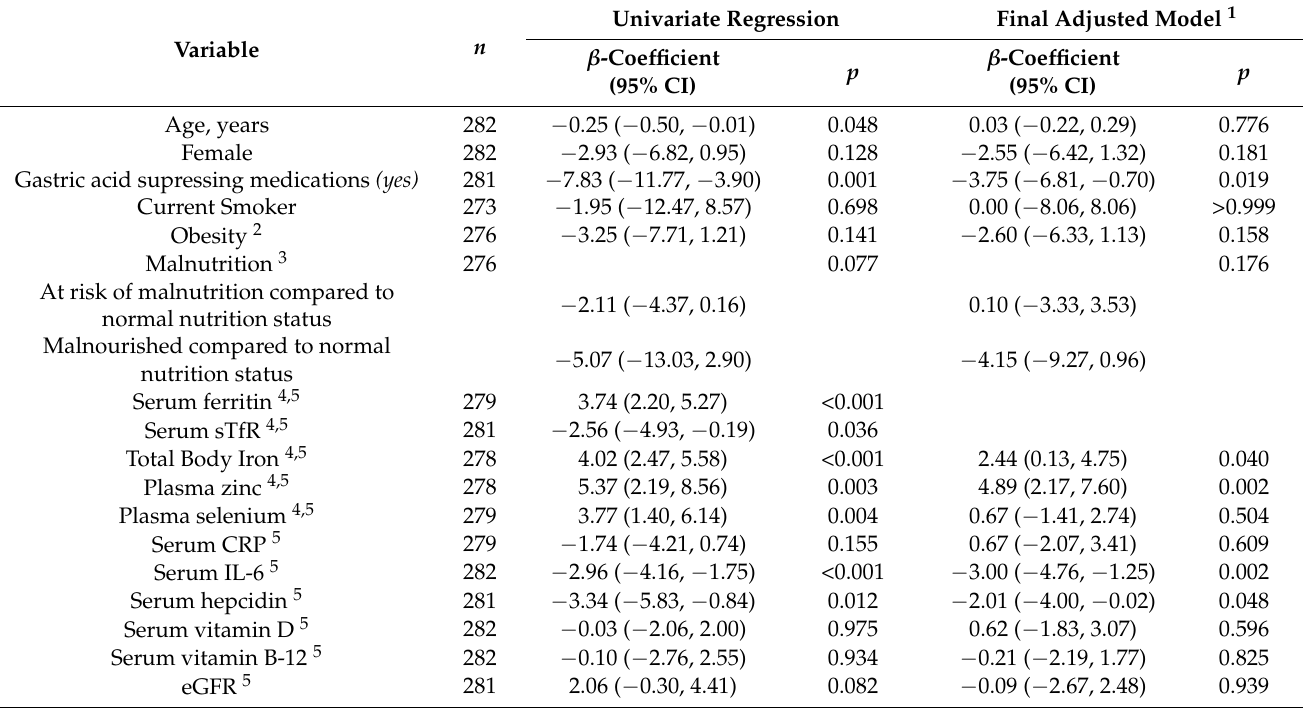
Table 2. Association of demographic, health, and biochemical factors with serum hemoglobin (g/L) among New Zealand aged-care residents of European ethnicity 1